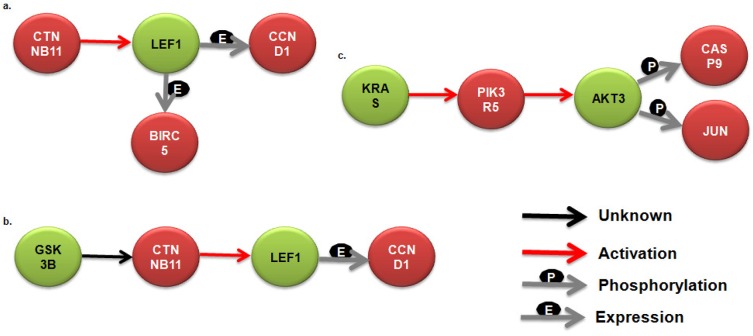
Identified network motifs from colorectal cancer pathway.Some 4 and 5 node sub-graphs have been symbolized with gene names and their interactions if any. If the given interaction in the pathway was found to be missing, it is depicted as unknown (black coloured arrow).